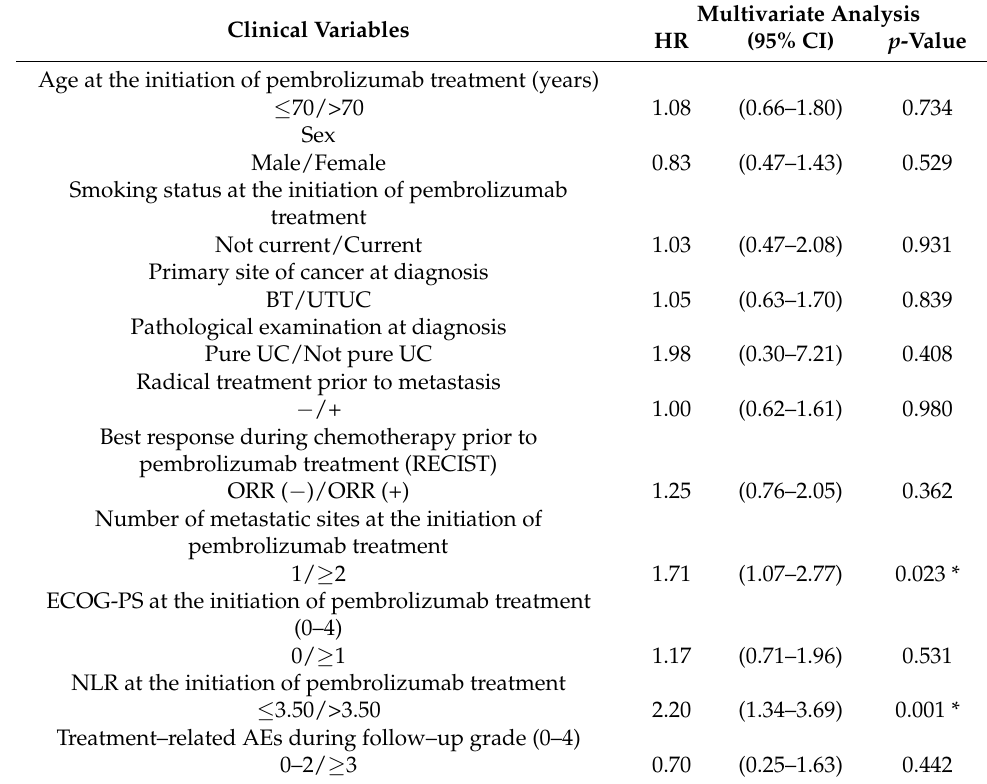
Figure 2. ( a ) Kaplan–Meier curves for overall survival (OS) from the initiation of pembrolizumab treatment according to the neutrophil–lymphocyte ratio ( ≤ 3.50/>3.50). ( b ) Kaplan–Meier curves for overall survival (OS) from the initiation of pembrolizumab treatment according to the number of metastatic sites (1/ ≥ 2). Table 2. Multivariate analysis for OS from the initiation of pembrolizumab treatment in 212 mUC